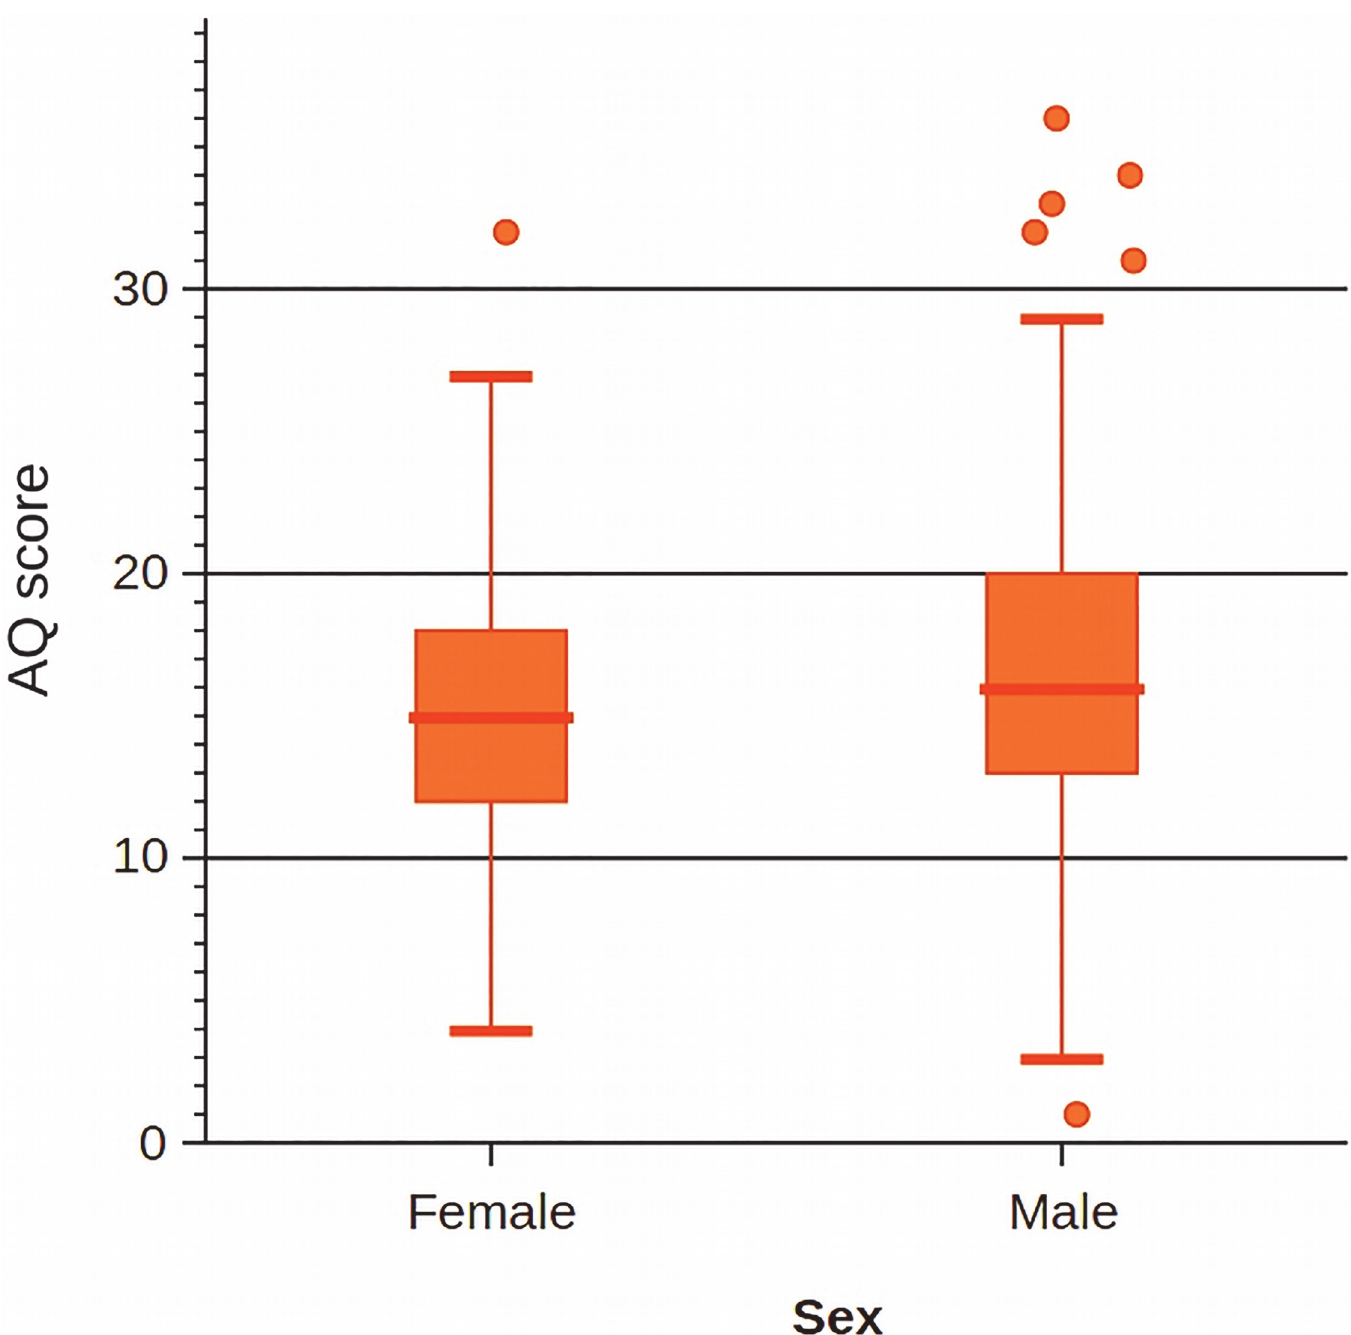
Fig 1. Box plot showing the differences between male and female subsamples. Whiskers and box bands denote quartiles.Comparison using Student ’ s t-test for independent samples showed that males scored higher than females (t(591) = 4.655, p < 0.001), meaning that the magnitude of autistic traits was higher in the